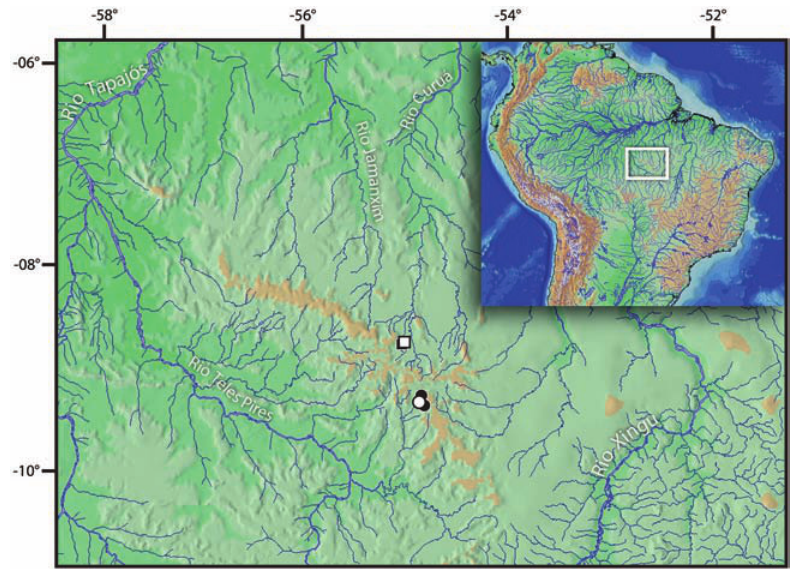
Fig. 4. Collecting sites and type-localities of Moenkhausia chlorophthalma (squares) and Moenkhausia plumbea (circles). Open symbols represent